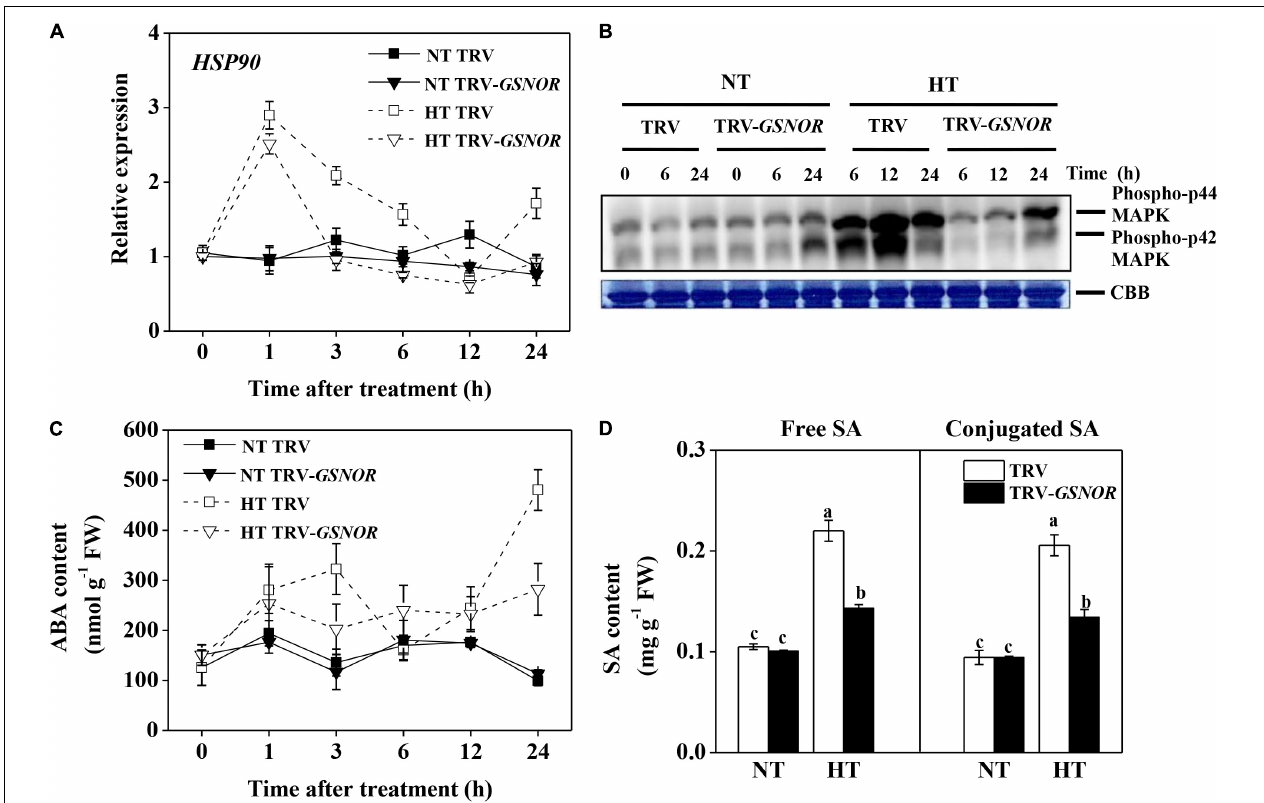
FIGURE 3 | Relative transcript level of HSP90 (A) , activation of MAP kinase (B) , accumulation of ABA (C) , and accumulation of free and glucose-conjugated SA (D) in SlGSNOR1 -silenced or TRV-empty vector infiltrated plants in response to high temperature (42 ◦ C/38 ◦ C) or normal temperature (21 ◦ C/16 ◦ C). For SA measurement, samples were taken at 24 h after heat stress. Data are means of five replicates ( ± SD). Means denoted by the same letter did not significantly differ at P < 0.05, according to Tukey’s test. NT, normal temperature; HT, high